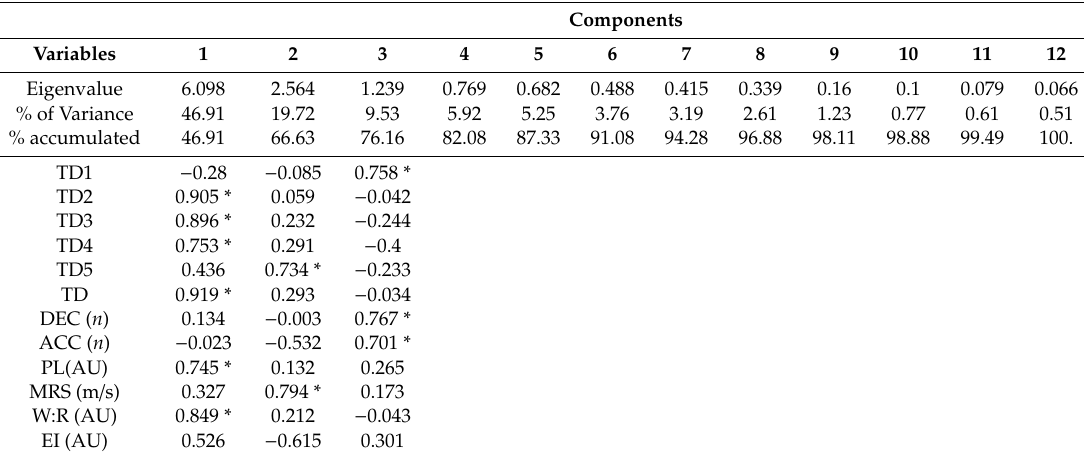
Table 3. Component analysis values.